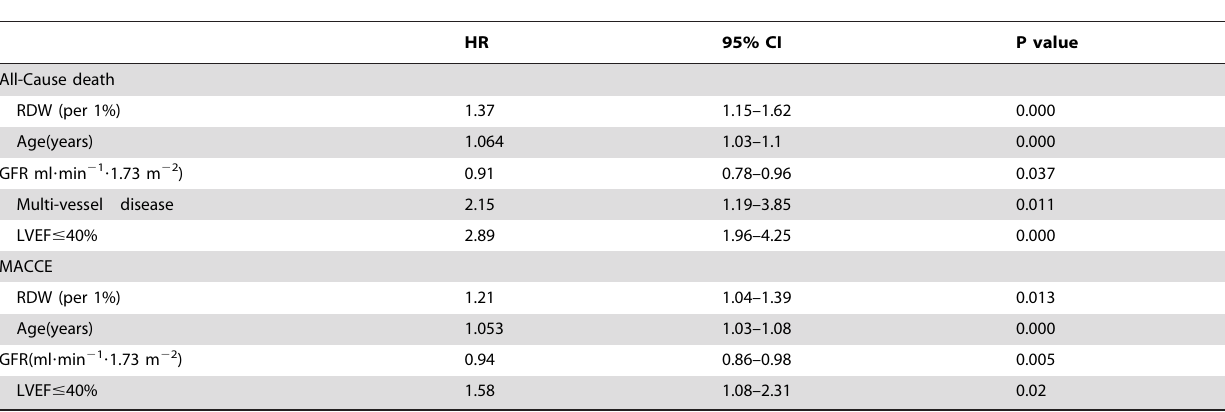
Table 6. Multivariate analysis for All-Cause Mortality and